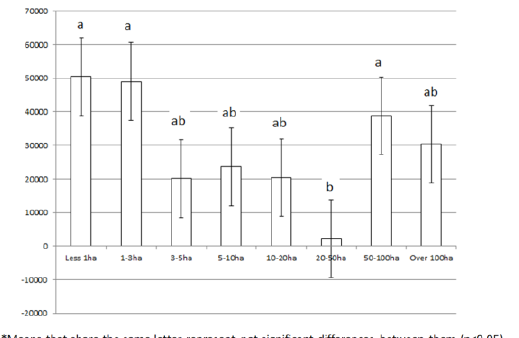
Figure 18. Total of pixels of areas with high or very high values of LUI per socio economic parameter. *Means that share the same letter represent not significant differences between them (p<0.05).